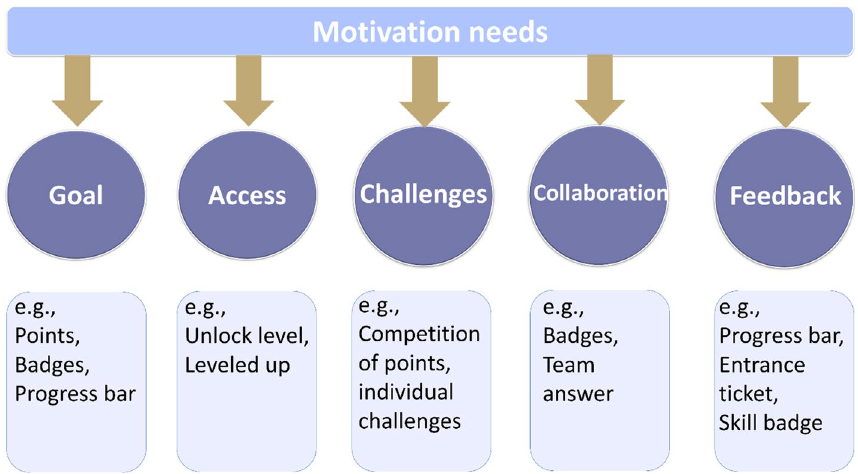
Fig. 3 Gamified design of the GAFCC model (adapted from Huang & Hew,